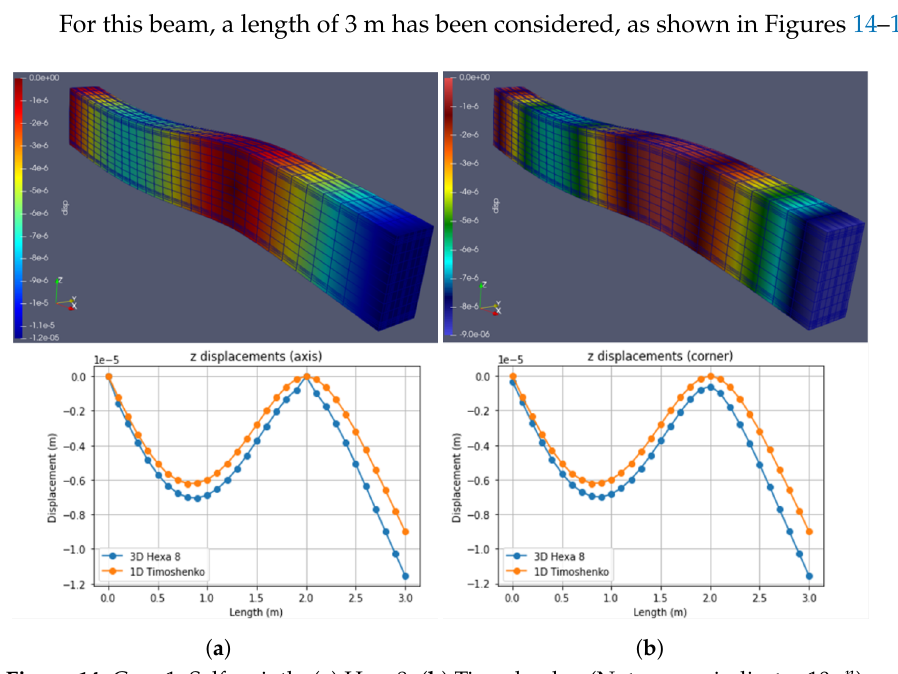
Figure 14. Case 1: Self weigth. ( a ) Hexa8. ( b ) Timoshenko. (Note: e − n indicates 10 − n